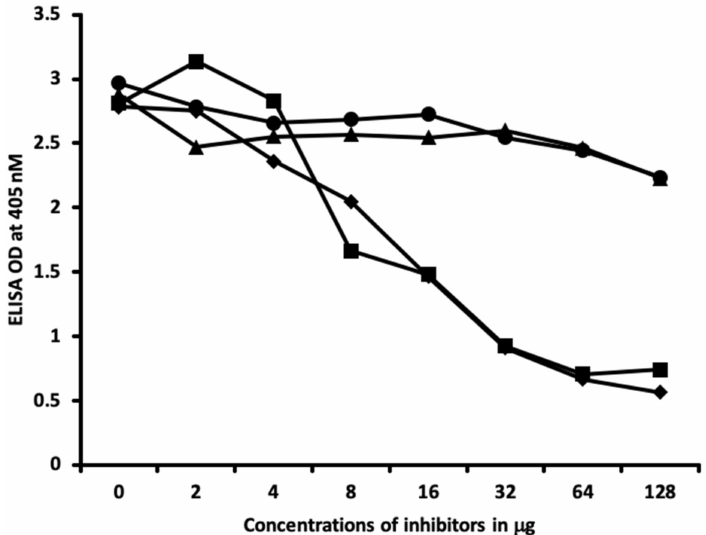
Figure 7. Binding of thyroid-stimulating hormone receptor antibody to isocyanate-HSA in the absence or presence of isocyanate aflatoxin, BPA-HSA, and 2,4-Din-HSA in concentrations of 0, 2, 4, 8, 16, 32, 64, and 128 µ g / mL. (cid:7) = Isocyanate; (cid:4) = aflatoxin-HSA; (cid:78) = BPA-HSA; • = DNP-HSA.